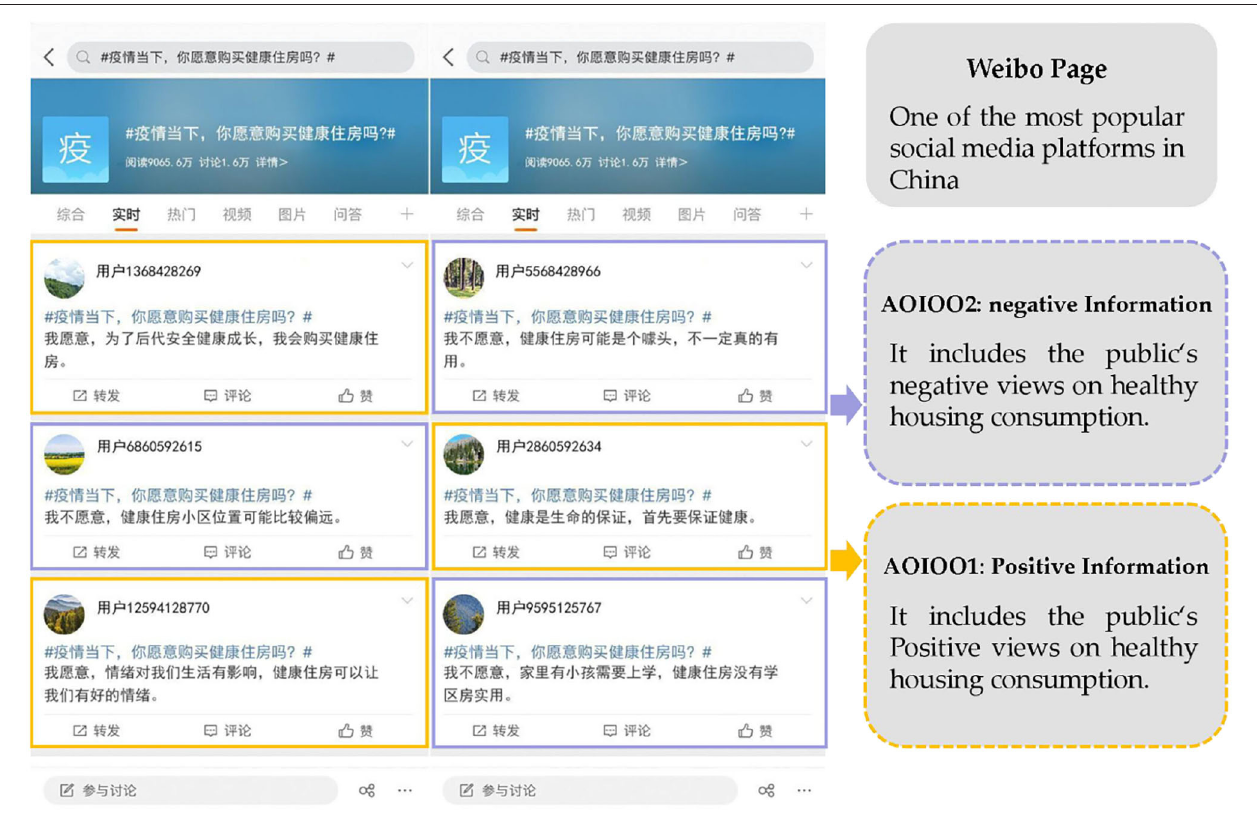
FIGURE 2 | Area of interest division map of Weibo